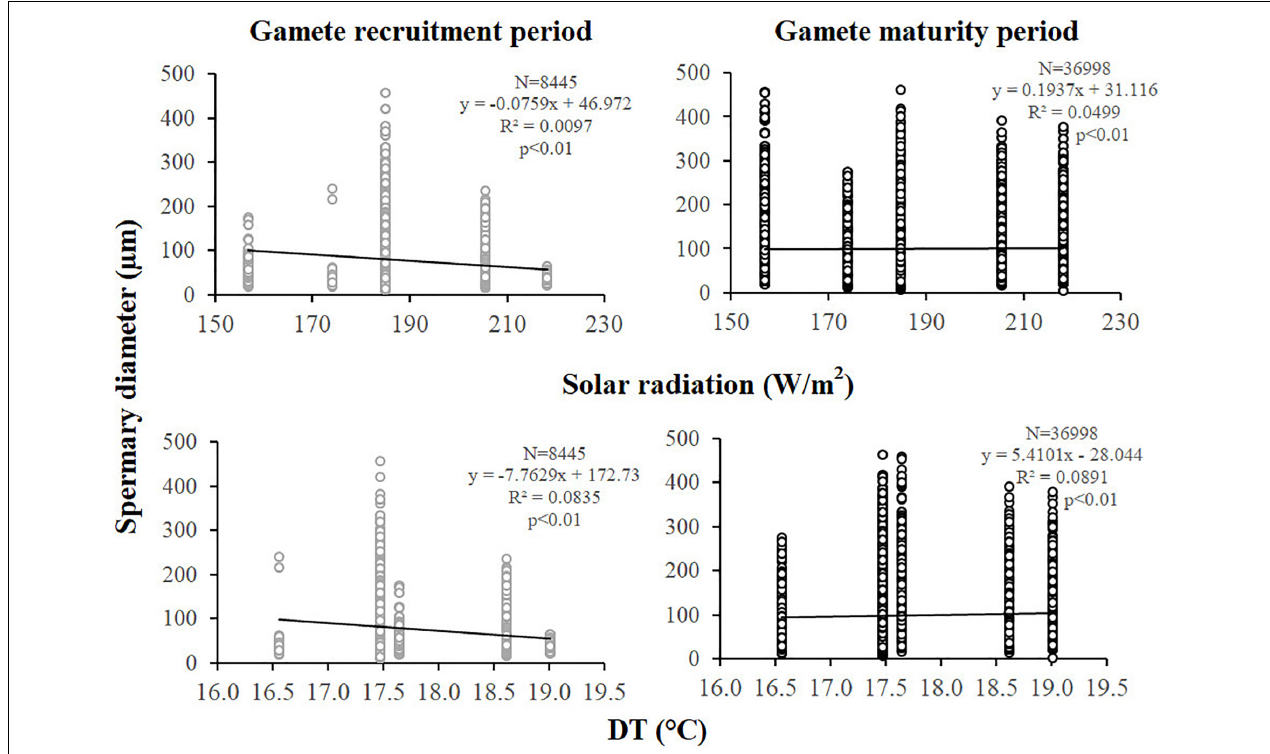
FIGURE 8 | Spermaries. Correlation analysis between spermary diameter and environmental parameters for gamete recruitment and maturity period. N , spermary number; R 2 , coefficient of determination; p , significance of p -value.